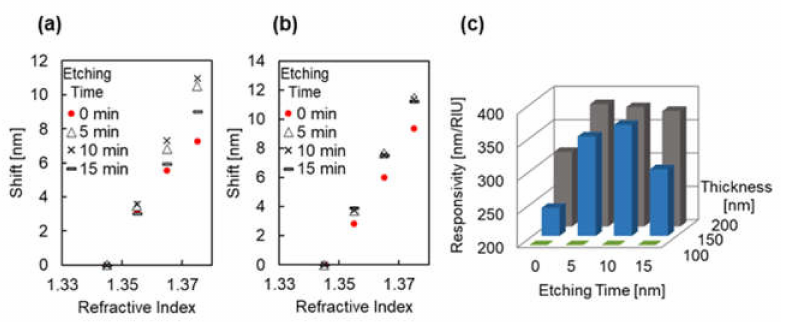
Figure 12. ( a , b ) Simulated peak shift due to refractive index changes under each condition of simulated plasmonic devices with Au layers with thicknesses of ( a ) 150 nm and ( b ) 200 nm. The red dots indicate (A), with a corresponding etching time of 0 min; the black hollow triangles indicate (B), with a corresponding etching time of 5 min; the black crosses indicate (C), with a corresponding etching time of 10 min; and the black horizonal lines indicate (D), with a corresponding etching time of 15 min. ( c ) Comparison of responsivity of each of the simulated plasmonic devices with different conditions.